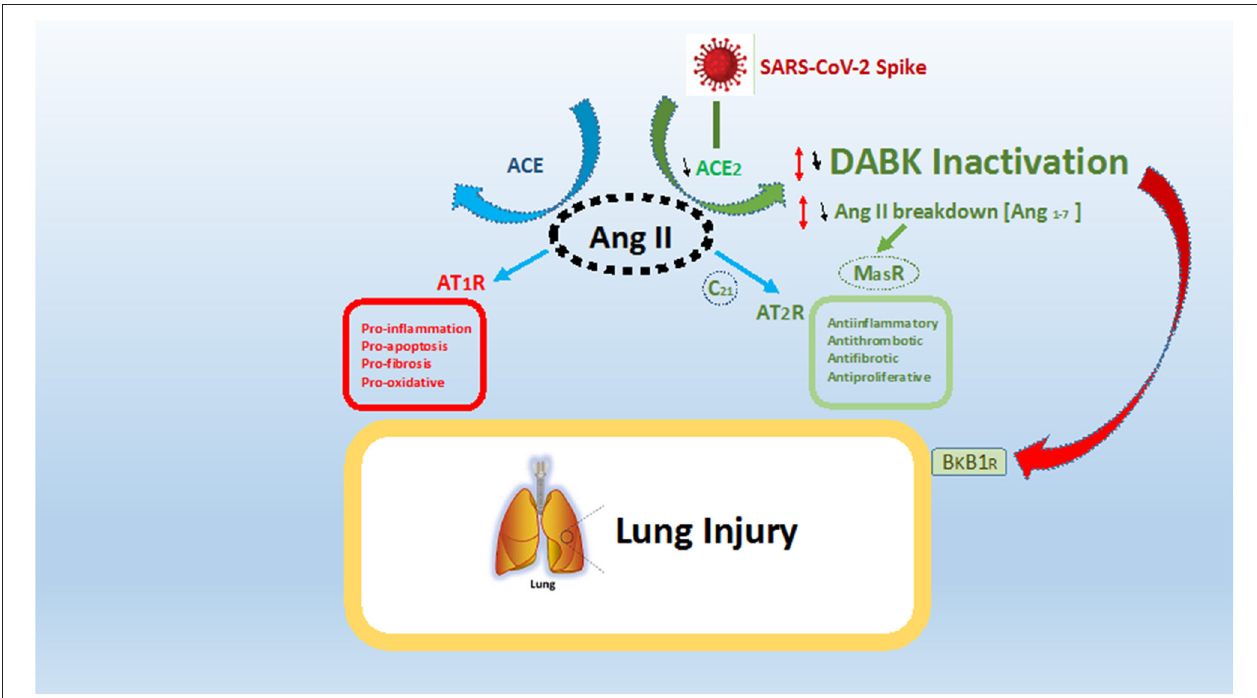
FIGURE 1 | ACE/ACE2 imbalance and effect in case of SARS-CoV-2 infection. SARS-CoV-2 spike protein ligates angiotensin conversion enzyme 2 (ACE 2 ) and leads to a relative deficiency in ACE 2 . Such deficiency leads to both an imbalance in the ACE/ACE 2 system and an over activation of the ACE pathway with over production of angiotensin 2 (Ang II) ligating the receptor AT1R. The present fact leads to a global pro-inflammatory, pro-fibrotic, and pro-oxidative state (in red). ACE 2 , through degradation of Ang II to angiotensin 1–7, leads to both a decrease in Ang II levels and stimulation of anti-inflammatory and anti-fibrotic pathways via AT2R and MasR (in green). Moreover, ACE 2 inactivate des-Arg-Bradykinin (DABK), which in the case of ligation to receptor Bradykinine-B1-receptor (BkB1R) leads to inflammation and vascular permeability (red arrow). In this regard, the final result of ACE 2 deficiency is both the promotion of lung inflammation and a decrease in lung anti-inflammatory effects, inducing SARS-CoV-2 acute respiratory